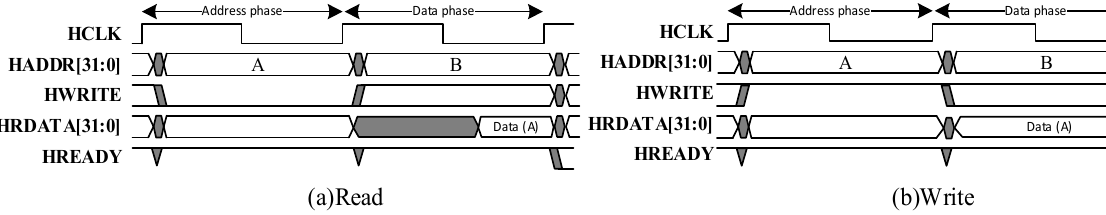
Figure 5. The read and write operations of the AHB protocol in the basic transmission mode.